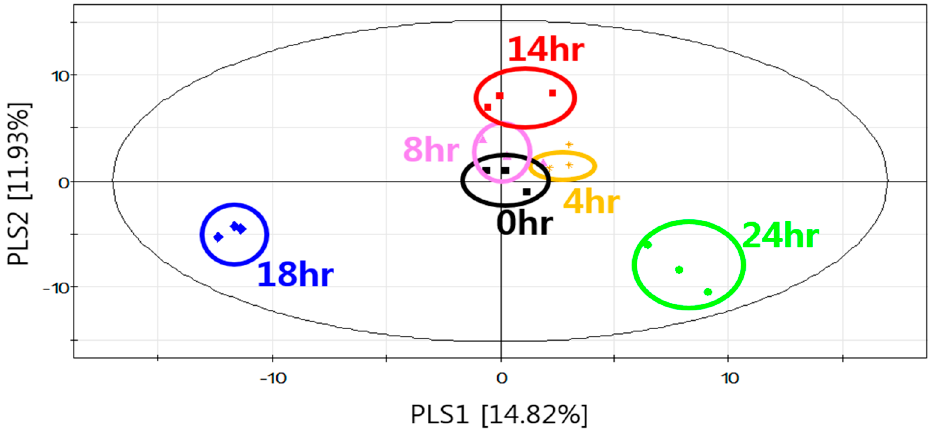
Figure 4. PLS-DA score plot for the nonvolatile metabolites of of S. fibuligera KJJ81 in YPD medium according to the cultivation time.